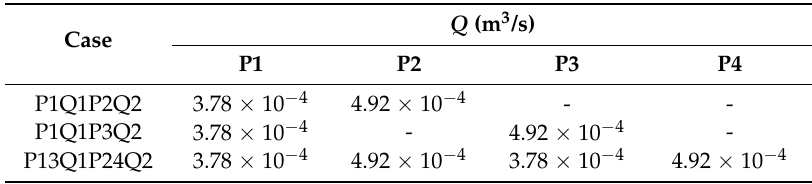
Table 2. Experimental conditions by inlet flowrates.